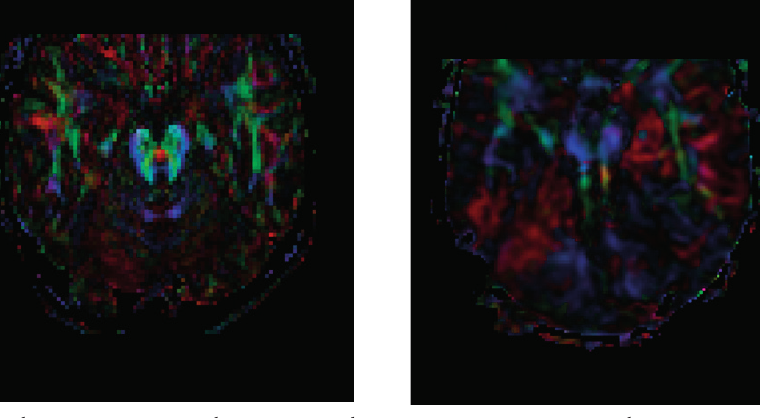
Fig. 1b. MRI 2D tractography in a normal child. Colour-coded functional anisotropic maps demonstrate the presence of a focal red dot anterior to the mesencephalon, adjacent to the interpeduncular fossa which represents the decussation of these fibre tracts.